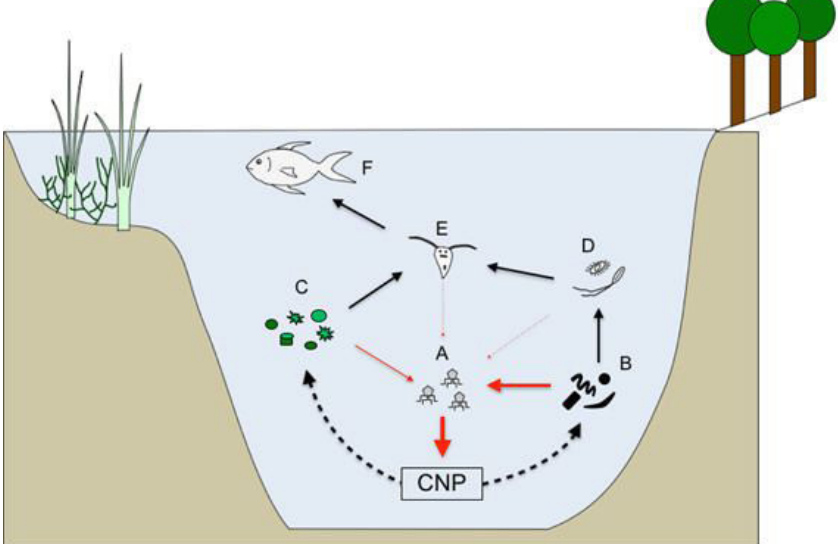
Figure 4. Illustration of the effects of the “viral loop” on aquatic food webs. Viruses (A) break host cells, which are often unicellular organisms such as bacteria (B) and phytoplankton (C), thereby releasing nutrients (carbon, nitrogen and phosphorus; CNP) into the water. In this way, viruses divert the amount of carbon that would reach higher trophic levels, such as microzooplankton (flagellates and ciliates - D), macrozooplankton (rotifers, cladocerans and copepods - E) and predators (e.g., fish - F), and release them back to the base of aquatic food webs (B and C). The black arrows indicate the regular flow of carbon in aquatic food webs, whereas the red arrows indicate the flows mediated by viruses. The width of the red arrows roughly represents the magnitude of these flows based on the relative abundance and biomass of these organisms usually found in aquatic ecosystems. Note that this is a theoretical picture and the width of the arrows may change between specific ecosystems. Figure adapted from Farjalla et al.